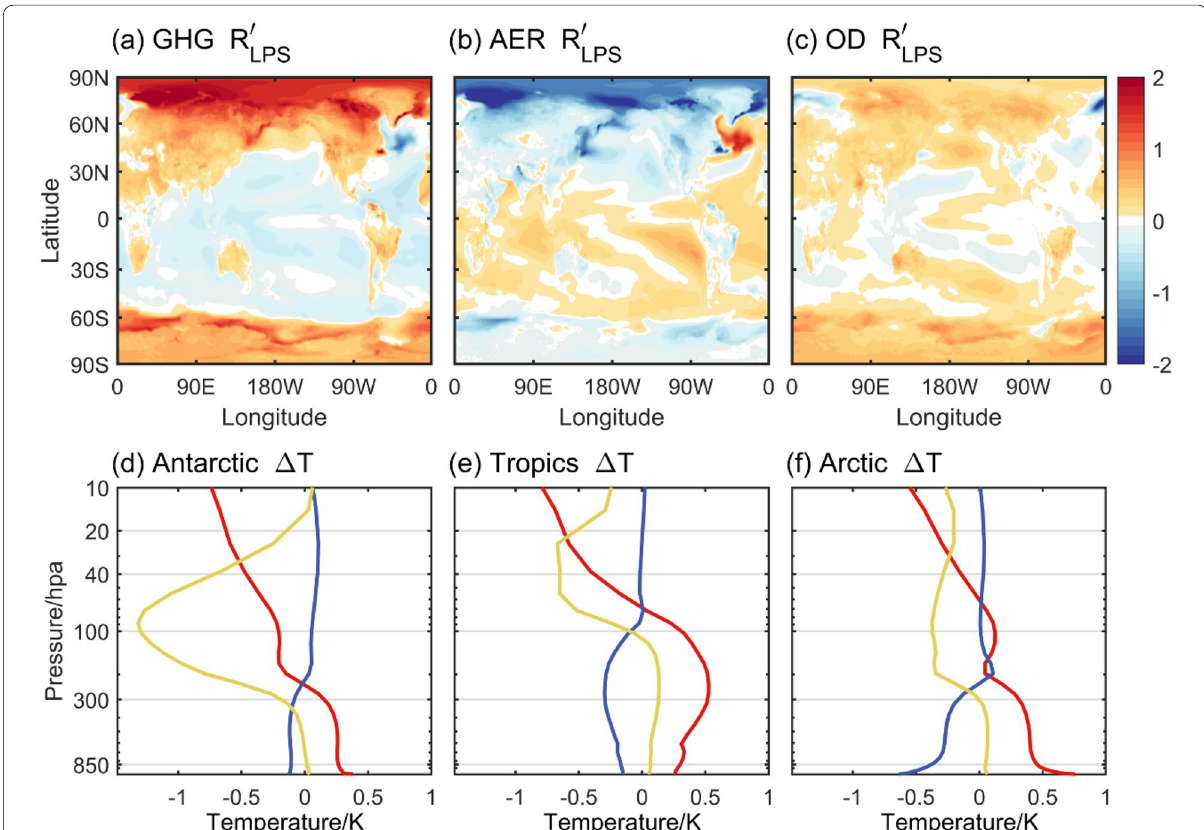
Fig. 4 Spatial pattern of lapse rate feedback contribution to the TOA heat flux ( W m − 2 ) due to a GHG, b AER and c OD. Vertical temperature changes ( K ) in the atmosphere due to GHG (red), AER (blue), and OD (yellow) in the d Antarctic (60°–90° S), e Tropics (25° S–25° N), and f Arctic (60°–90°